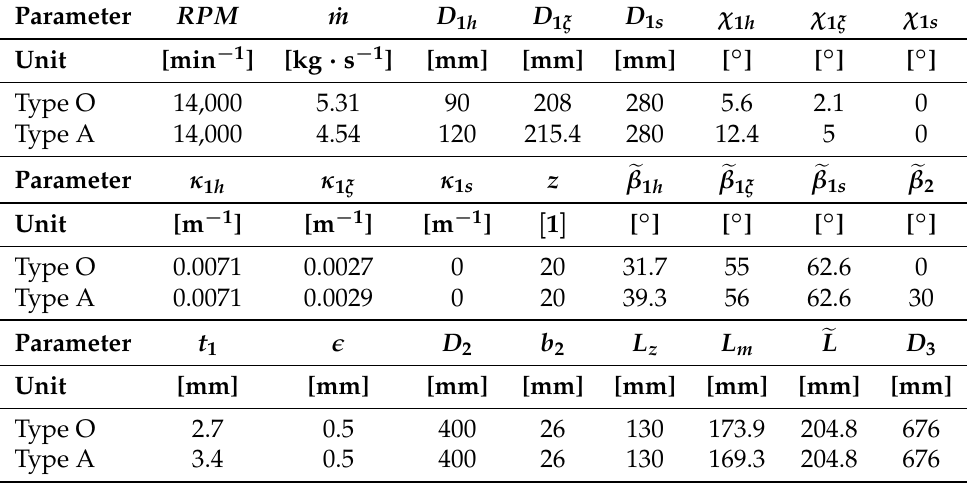
Table 1. Algorithm input